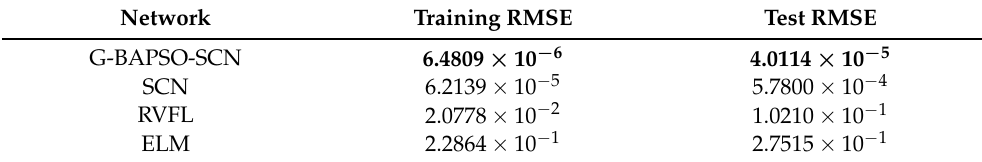
Table 9. Performance comparison results (Dataset 2).